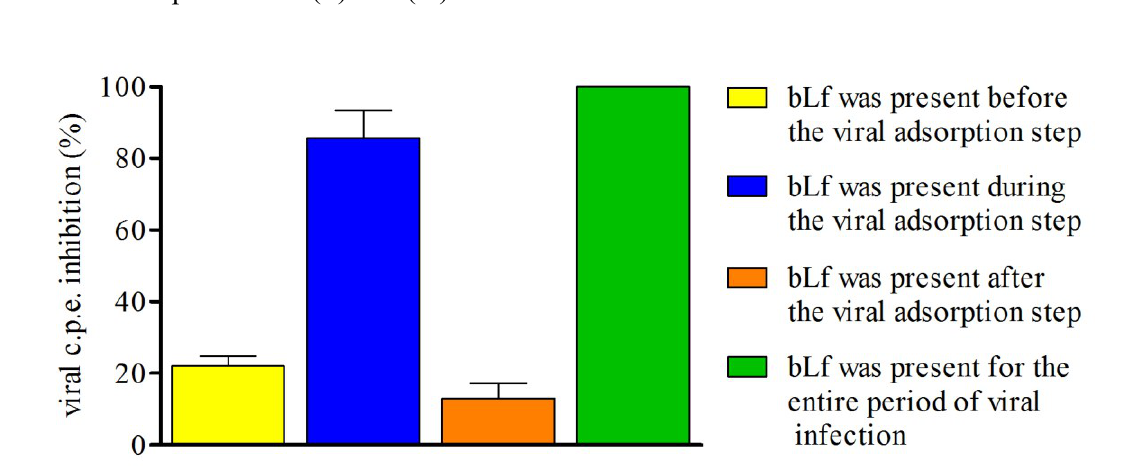
Figure 2. Effect of bLf on different steps of TosV infectious cycle. Monolayers of Vero cells were infected with TosV (m.o.i. 1) and treated with bLf (1mg/mL) during different phases of infection: ( A ) before virus inoculation; ( B ) during virus inoculation; ( C ) after virus inoculation; and ( D ) throughout infection. After 48 h of infection the viral c.p.e. was measured by neutral red uptake assay. Data showed represent the mean of at least quadruplicate